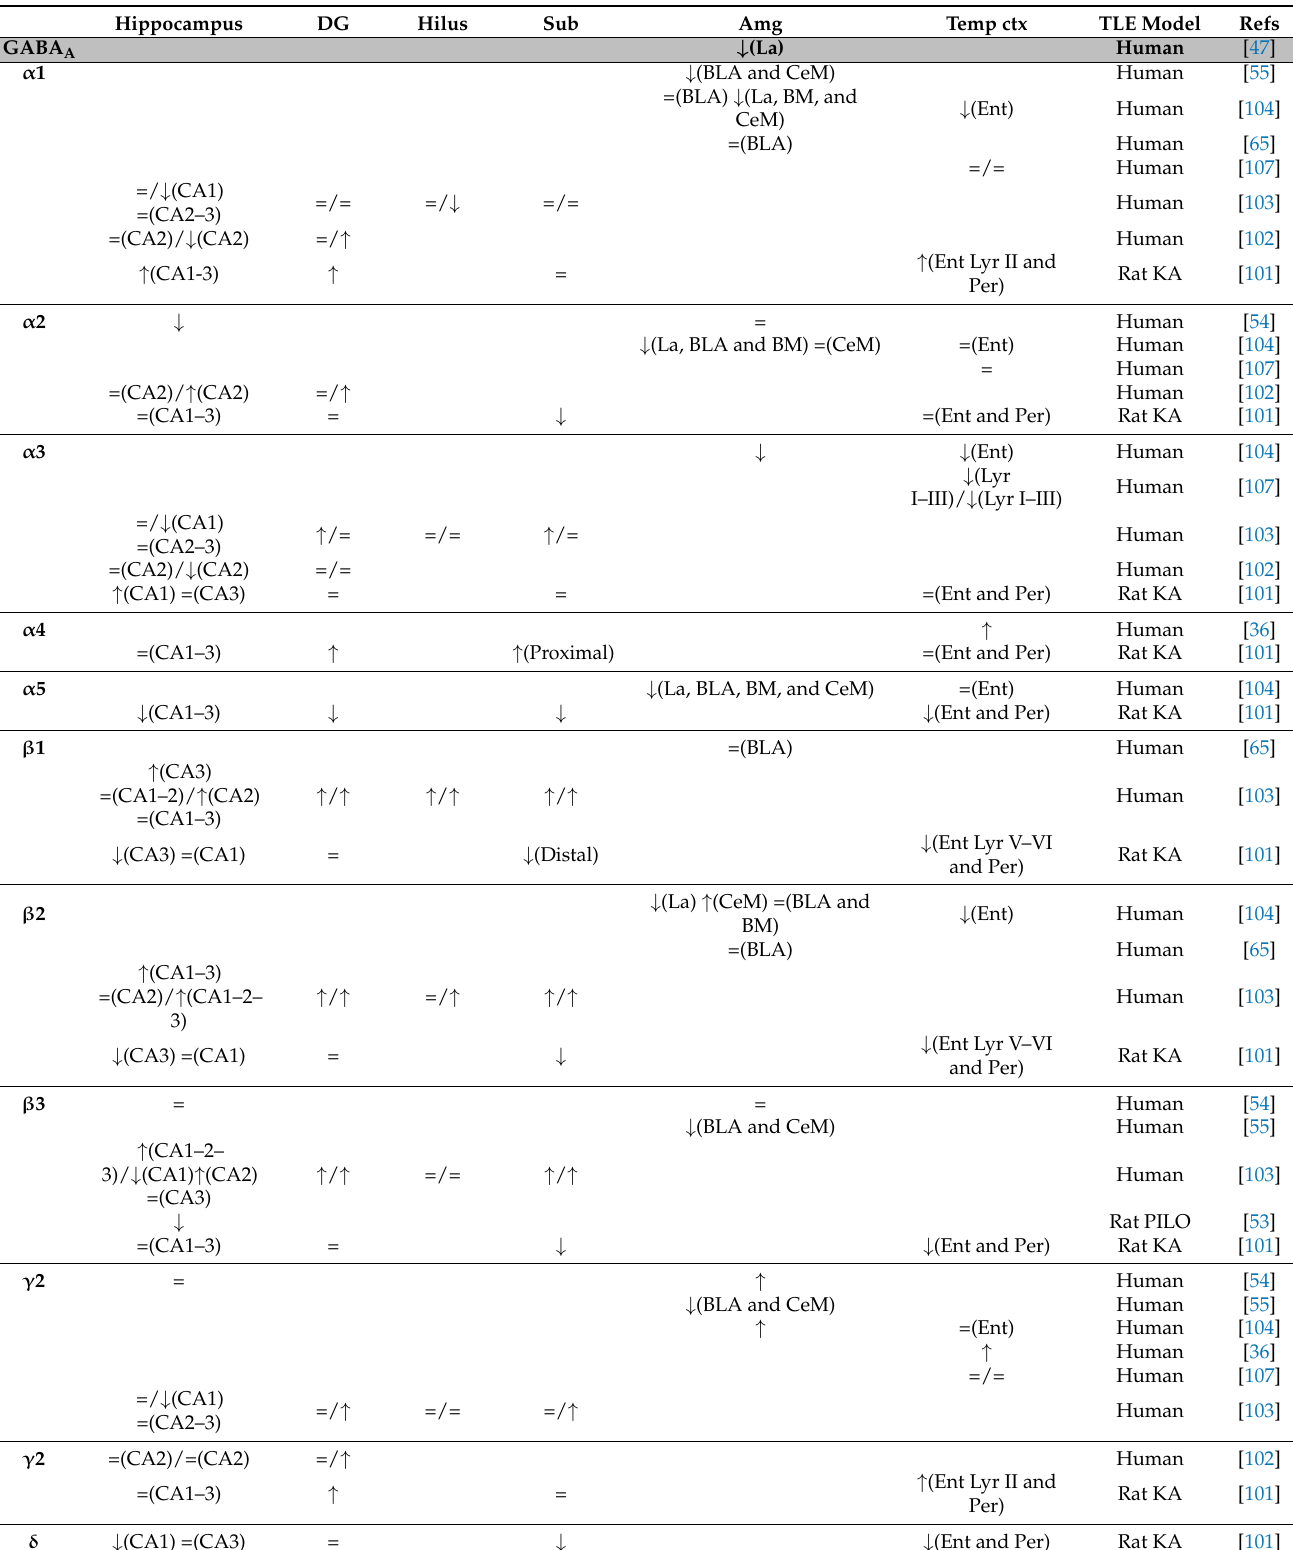
Table 3. Alterations of neuronal GABAergic ionotropic